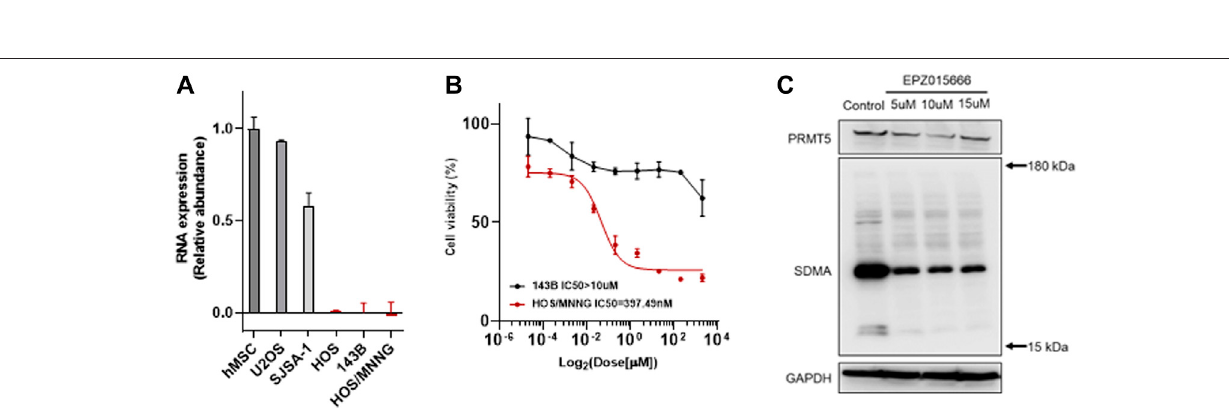
Frontiers in Bioengineering and Biotechnology |